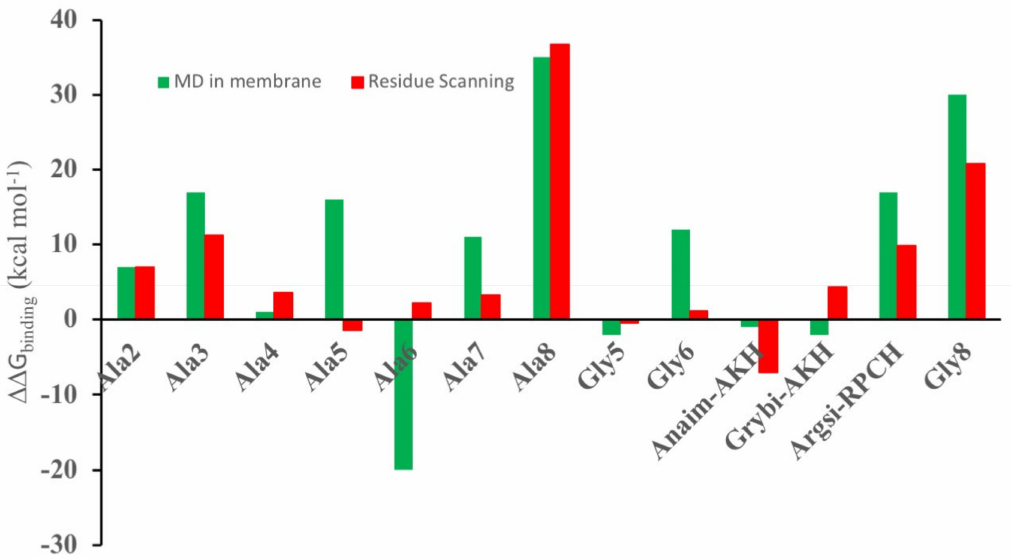
Figure 2. ∆ G binding relative to Dappu-RPCH binding to Dappu-RPCHR ( ∆ G mutate − ∆ G Dappu ). Red bars are from residue Scheme 50. ns simulation of the mutated ligand bound to the receptor in a POPC membrane. Results for [Ace]Dappu- RPCH and [COOH]Dappu-RPCH are not included, as they did not have residue scanning, mutation options of the Schrödinger